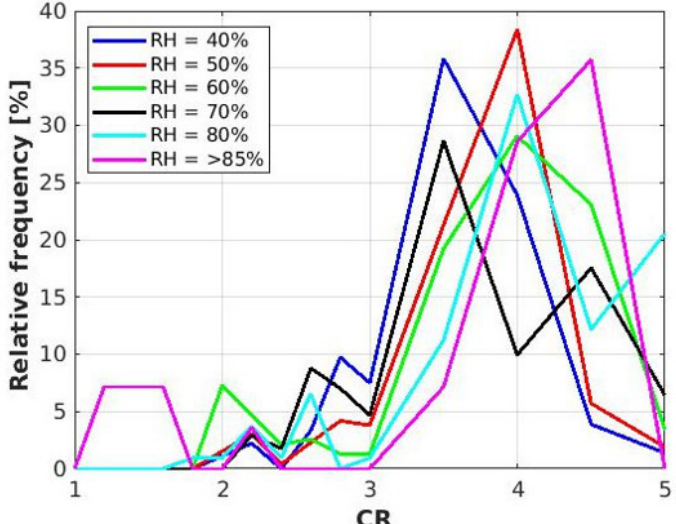
Figure 10. The colour ratio for different values of the RH between 1500 and 2000 m altitude. The dif- ferent colours indicate the RH